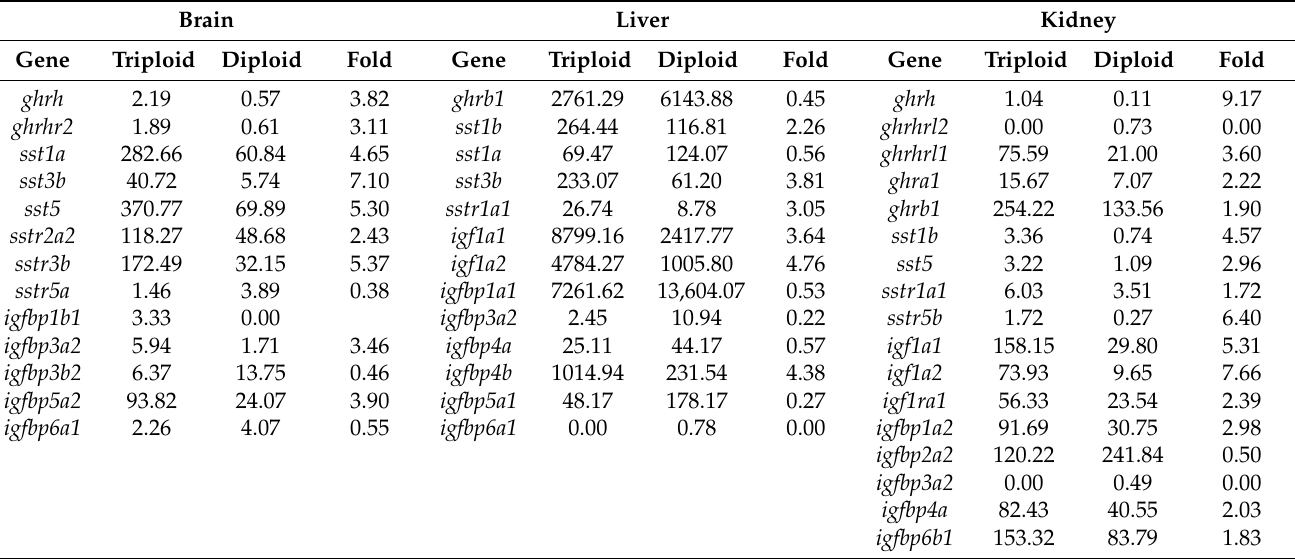
Table 2. Comparison of ghrh-gh-sst-igf axis between diploid and triploid